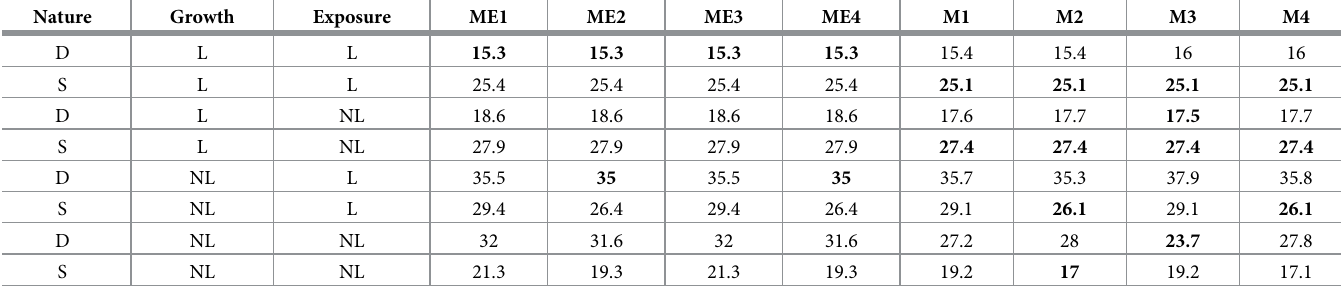
MSE, Mean Squared Error; ME, Mixed Effect Model; M, Growth Mixture Model; D, Deterministic; S, Stochastic; L, Linear; NL, Non-Linear Models 1, 3 assume linear mean; Models 2, 4 assume quadratic mean. Models 1, 2 use random intercept; Models 3, 4 use random slopes.